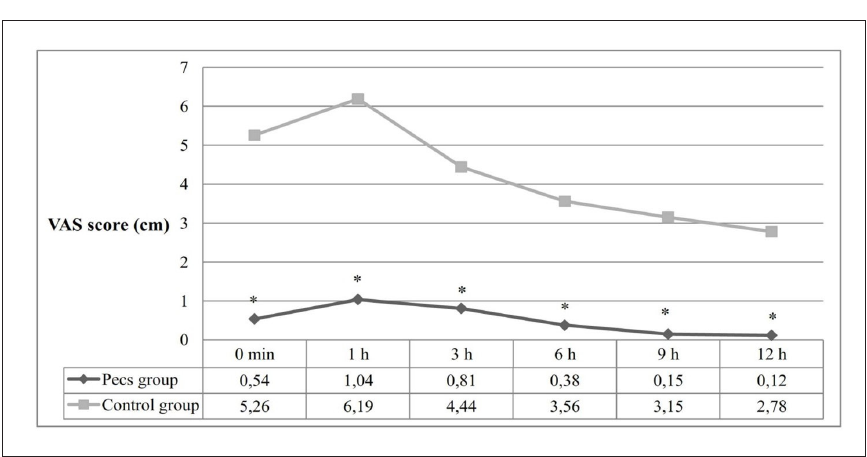
Figure 2. Postoperative Visual Analog Scale scores. (Data are presented as mean. VAS: Visual Analog Scale. The groups were compared by t test after repeated measures ANOVA. * p <0.05, comparisons between the groups.)